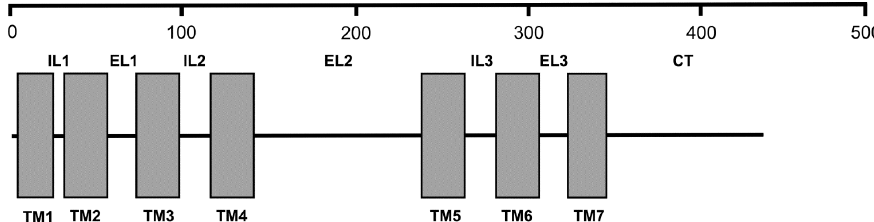
Figure 3. Schematic domain organization of BsC3a/C5aR protein. Numbers refer to the length of the amino acid sequence. IL: intracellular loop; EL: extracellular loop; CT: cytoplasmic tail; TM: transmembrane domain.